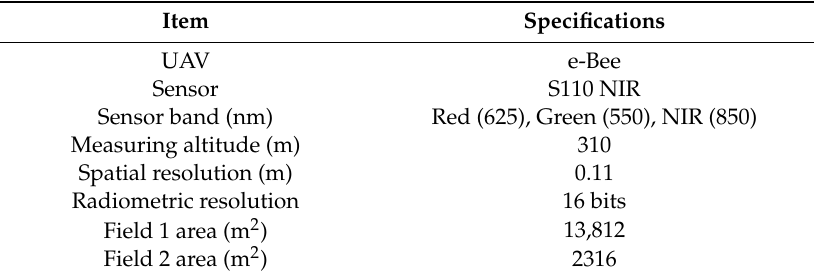
Table 1. On-site measuring instruments and observation conditions.